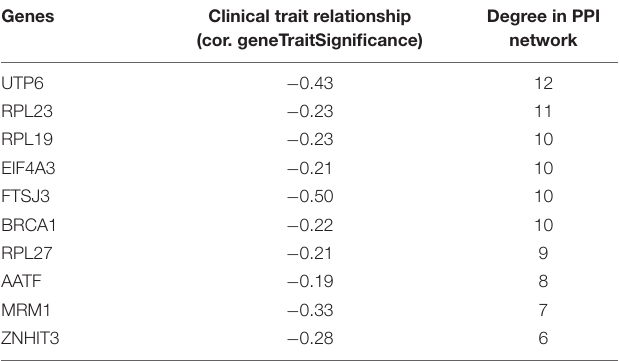
TABLE 1 | Hub genes. Genes Clinical trait relationship (cor. geneTraitSignificance)